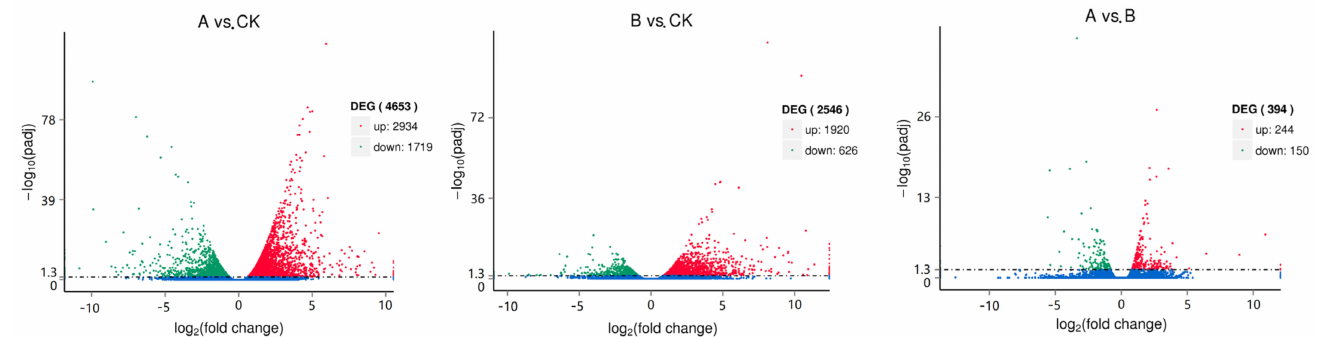
Figure 5. Volcanic map of differentially expressed genes in foliar and root selenium application treatments. Note: CK control group; A—foliar spraying; B—root pouring.